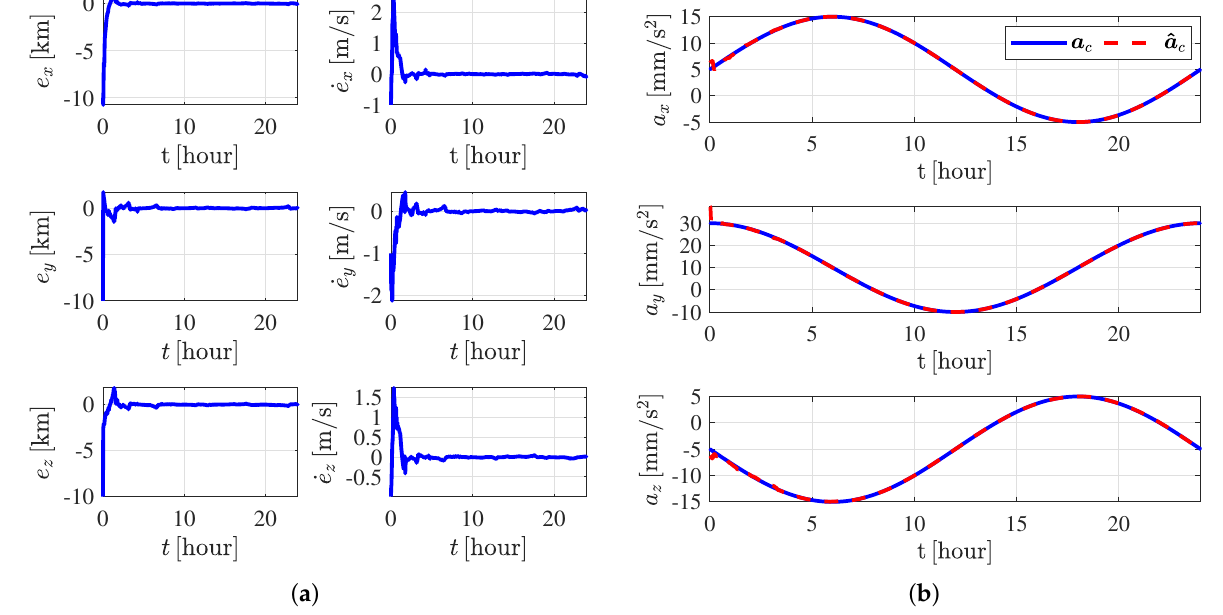
Figure 10. OD results using the eighth-order polynomials. ( a ) State estimated errors. ( b ) Maneuver estimated comparison (the blue lines denote the real maneuvering acceleration and the red dashed lines represent the estimated maneuvering